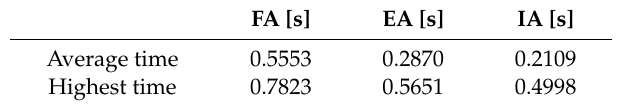
Table 2. The average and the longest travel times of the ants in the approach with reservations (WRA).